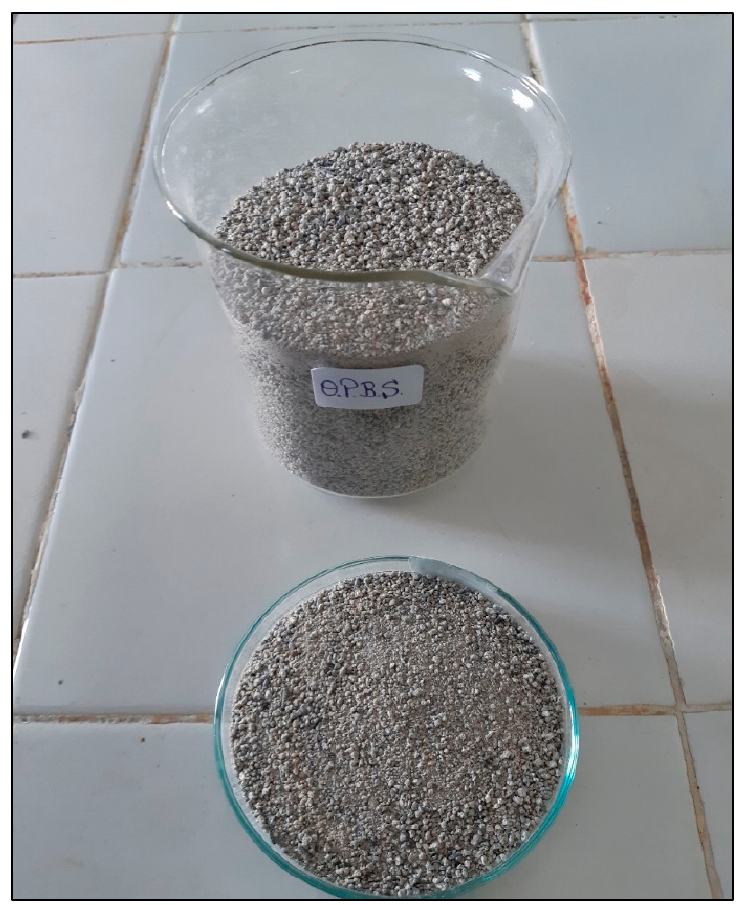
Figure 1. Slag residue from olive pomace combustion (OPBS) .